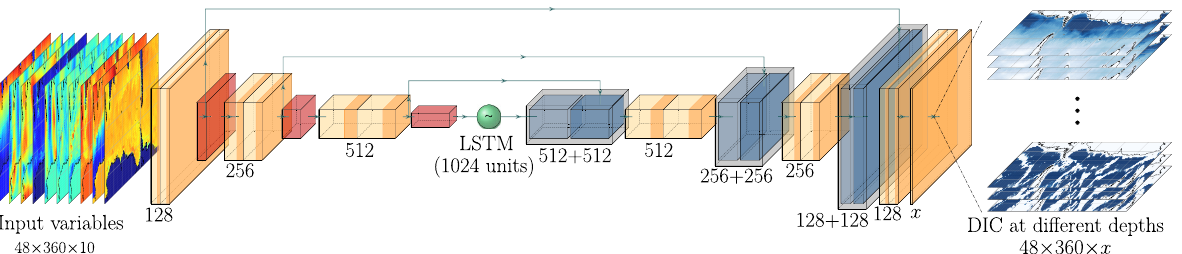
Fig. 6 Schematic diagram of the U-net model. The green circle with a tilde in the middle denotes the long-short-term memory (LSTM) cell with 1024 units, which connects the encoder (the 9 layers on the left hand side) with the decoder (the 13 layers on the right hand side). The 3 × 3 convolutional layers are in light orange followed by the ReLU activations in dark orange. The 2 × 2 max pooling layers are in red. Light blue layers are the 2 × 2 up-convolutional layers, which are concatenated (shown as the gray boxes) with the forwarded features (shown as the dark blue layers) from the encoder. The arrows denote the residual learning connections that forward from the encoder to the decoder. To improve computational ef fi ciency, x vertical layers are trained simultaneously. x = 2 from the ocean surface to 2 km depth and x = 3 for 2 – 4